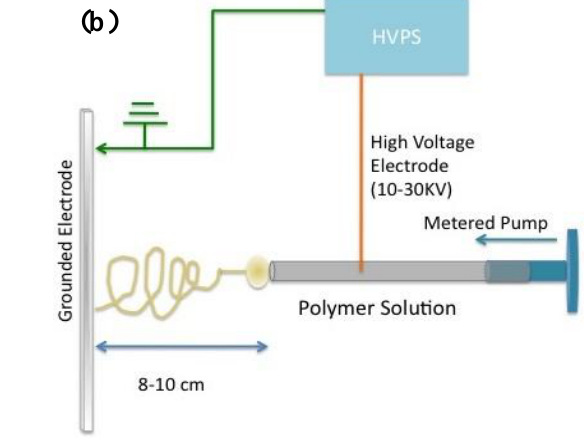
Figure 1. (a) Chemical structure of poly acrylic acid; (b) Schematic diagram of the electrospinning